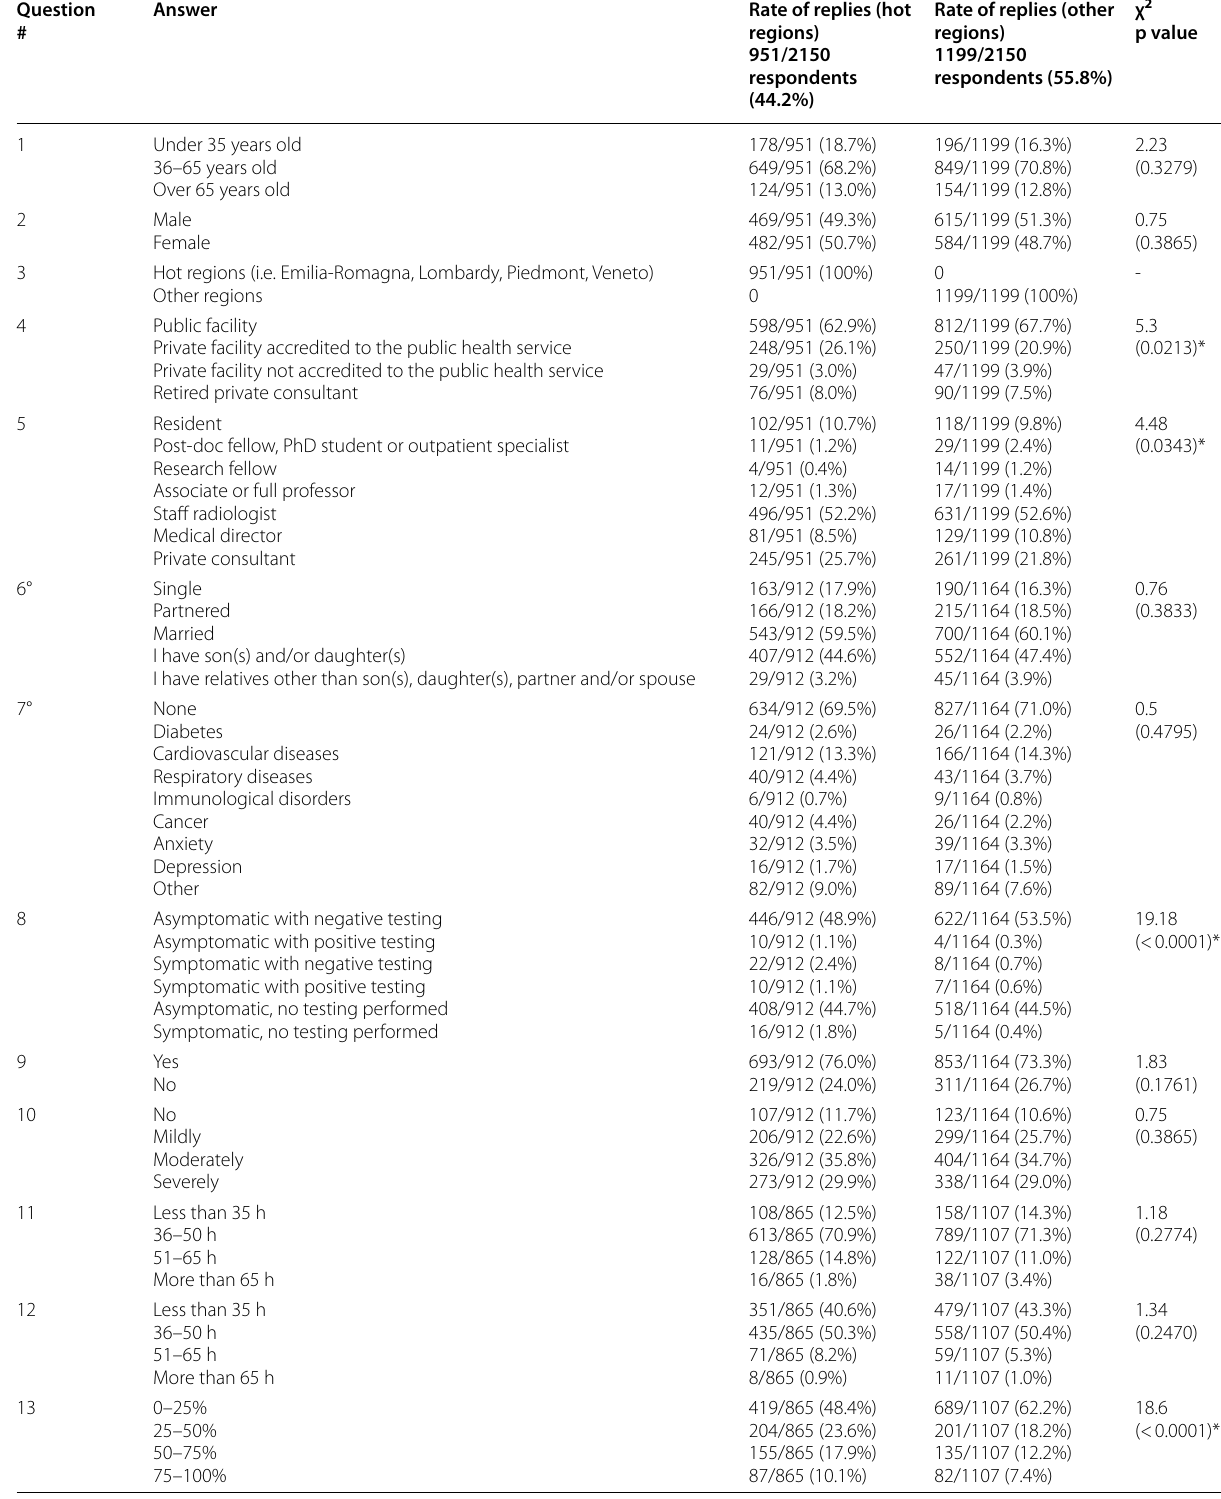
Table 1 Distribution of answers in hot and other regions (see Supplement 1 for full list of answers). Question